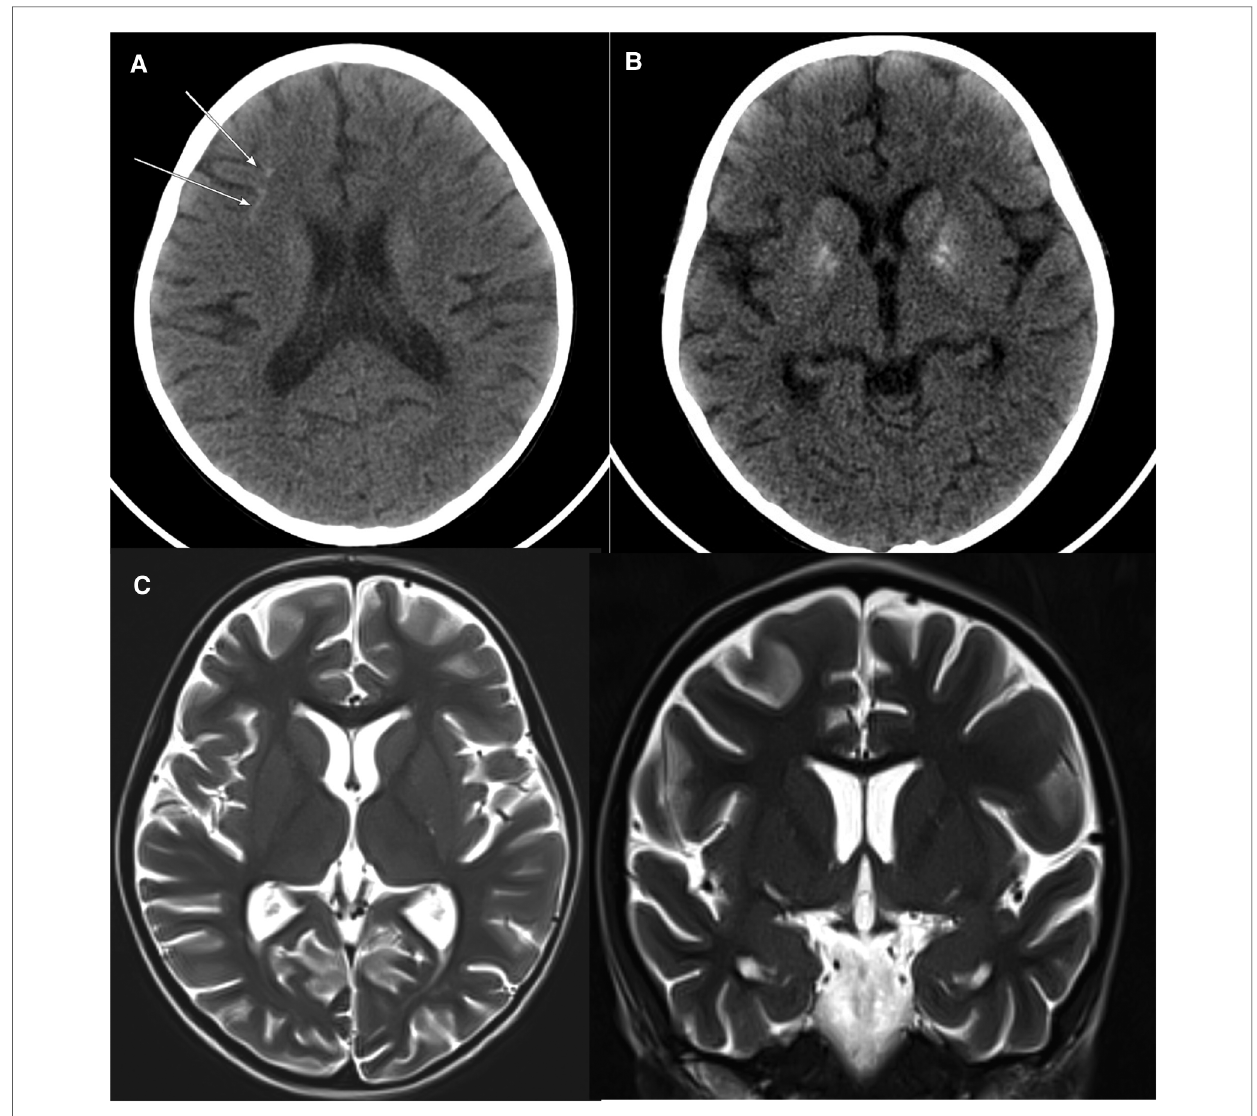
FIGURE 1 Axial non-contrast CT brain with soft tissue window: there is a faint subcortical calci fi cation at the right frontal lobe ( A ) and almost symmetrical calci fi cation within the basal ganglia ( B ). Axial and coronal TW2 Brain MRI: Mild generalized brain atrophy was noted. Gyration, myelination, and brain morphology are otherwise normal ( C